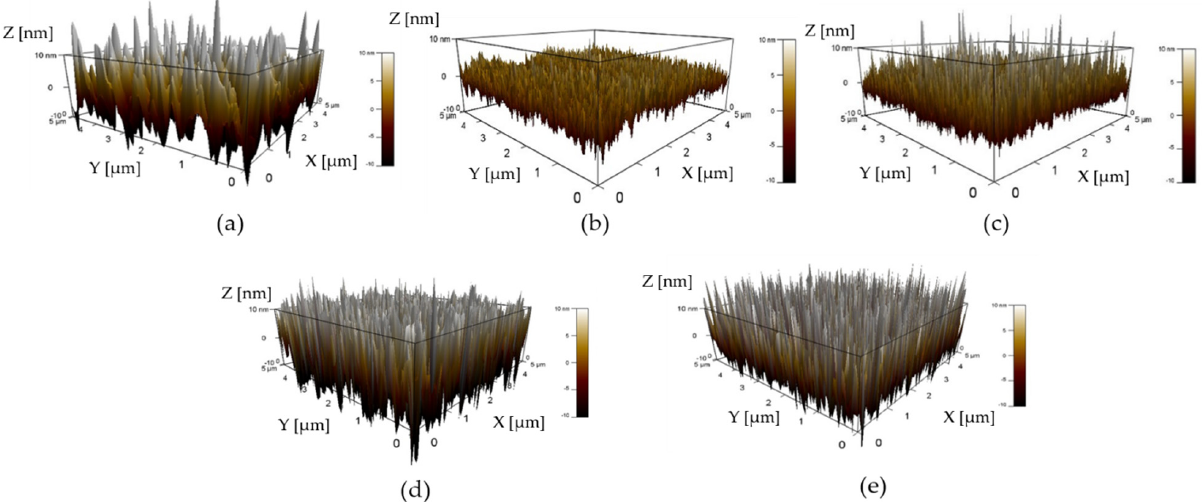
Figure 1. AFM images of AZO films with different Al doping ratios by the mist CVD method: ( a ) 1